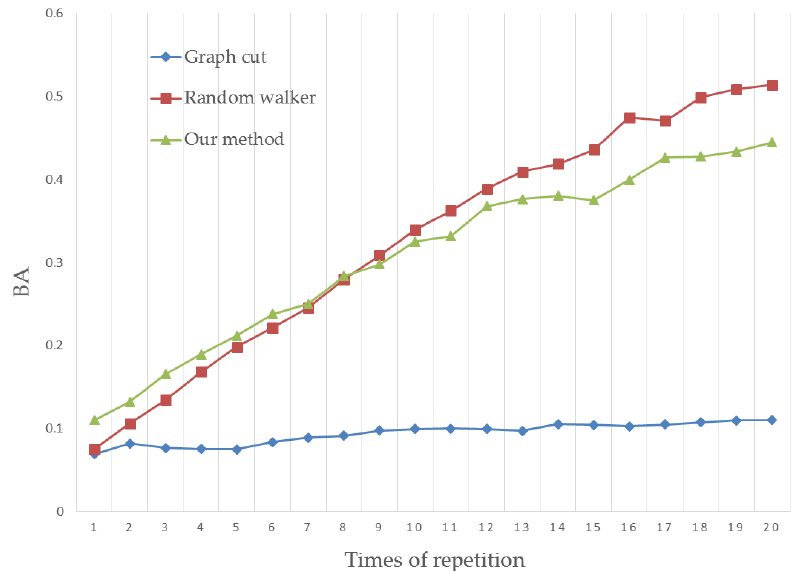
Figure 14. Boundary accuracy comparison.